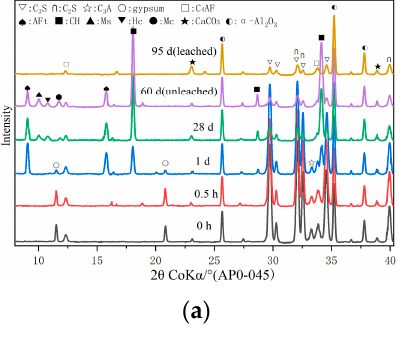
Figure 6. The phase composition of hydrated and leached PA0-045 cement pastes: ( a ) XRD; ( b ) the content of phase composition.